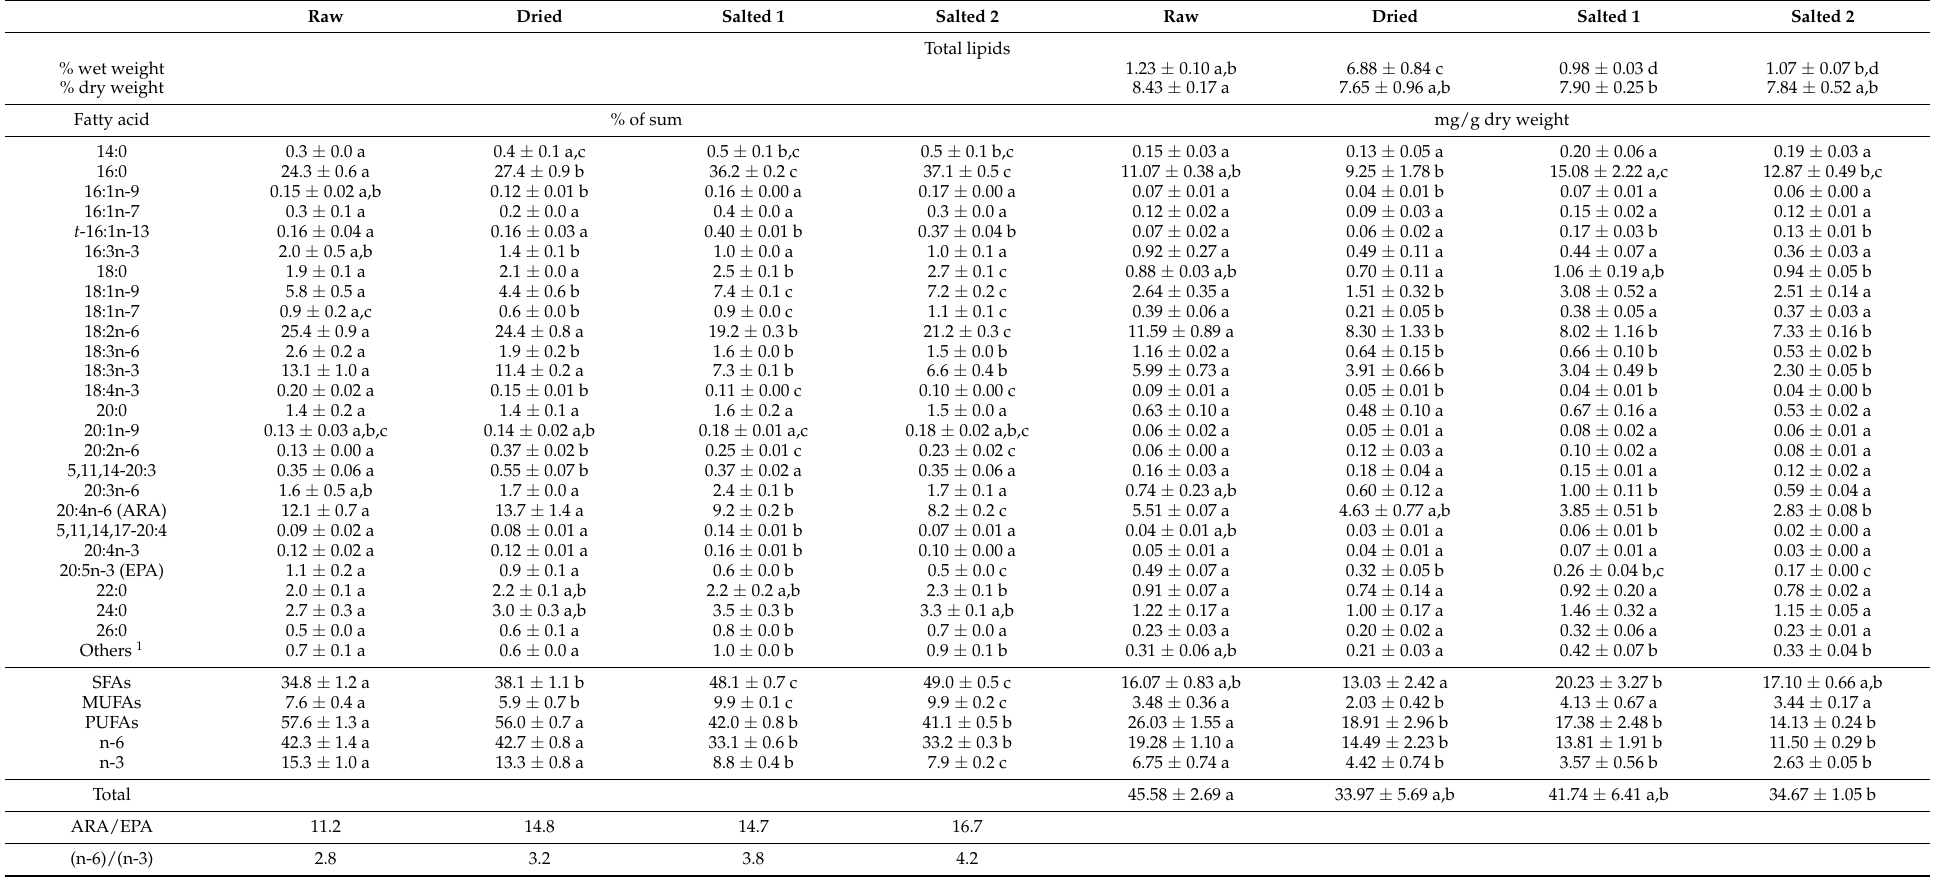
Table 2. Lipid and fatty acid content of raw and processed fiddleheads of bracken fern ( Pteridium aquilinum